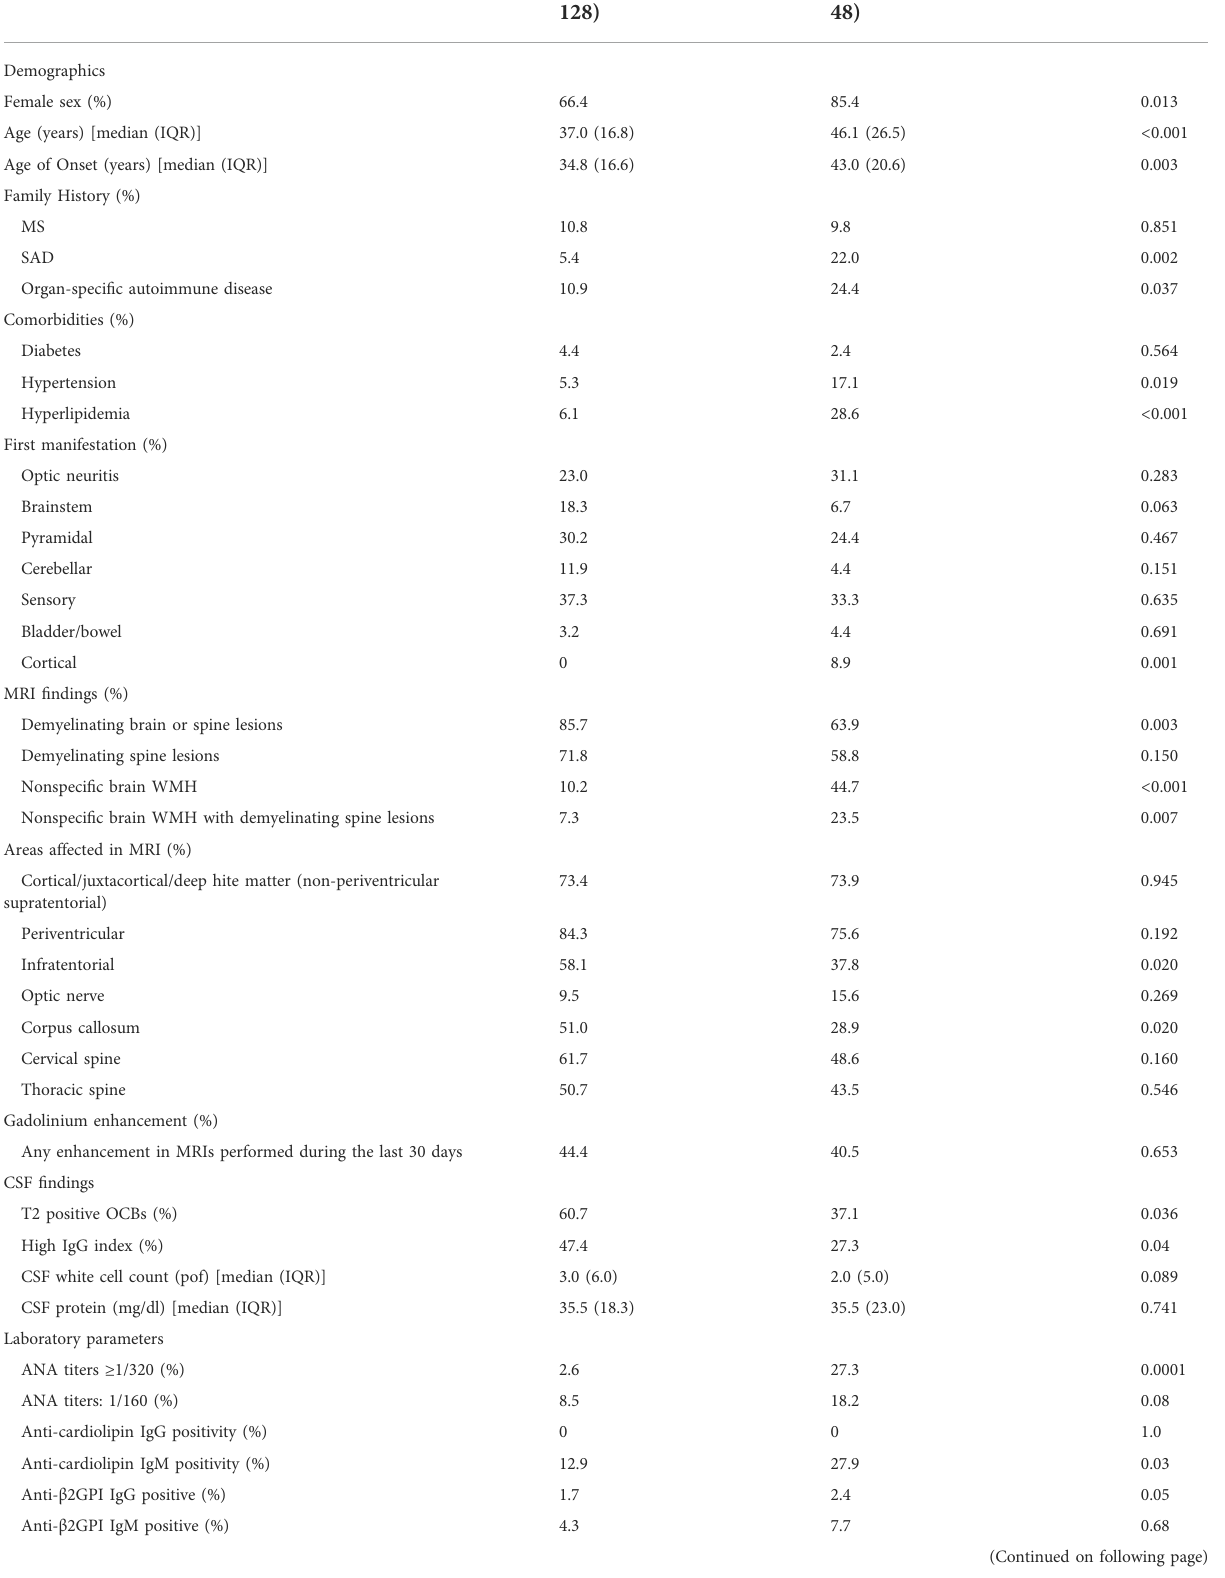
TABLE 3 Comparative analysis between MS spectrum and CNS autoimmune